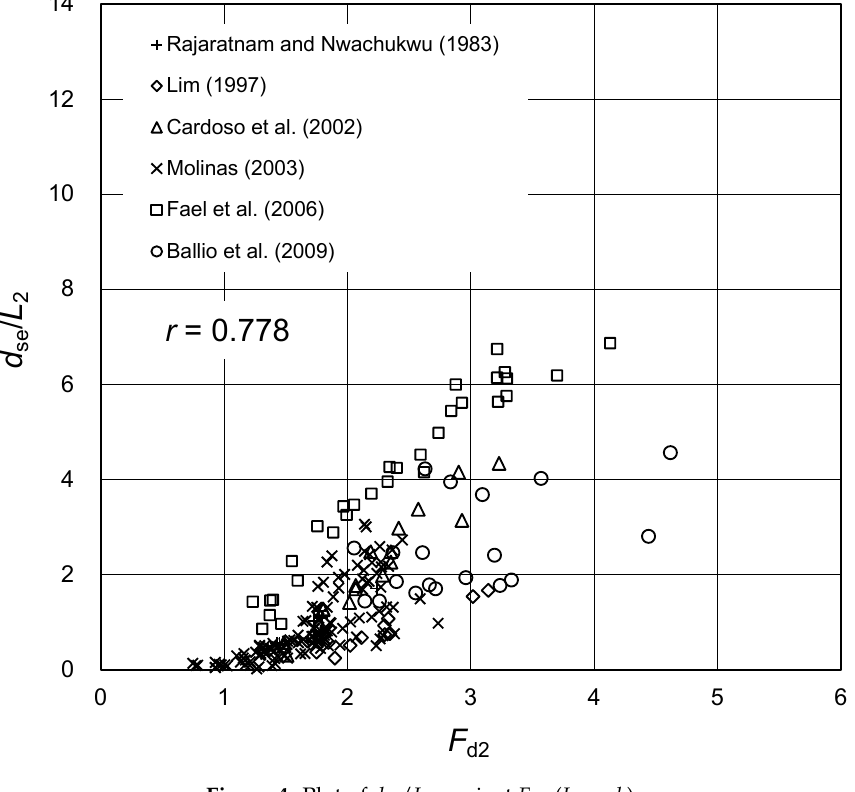
= ℎ ). ( (cid:1838) (cid:3031)(cid:2870) (cid:2870)